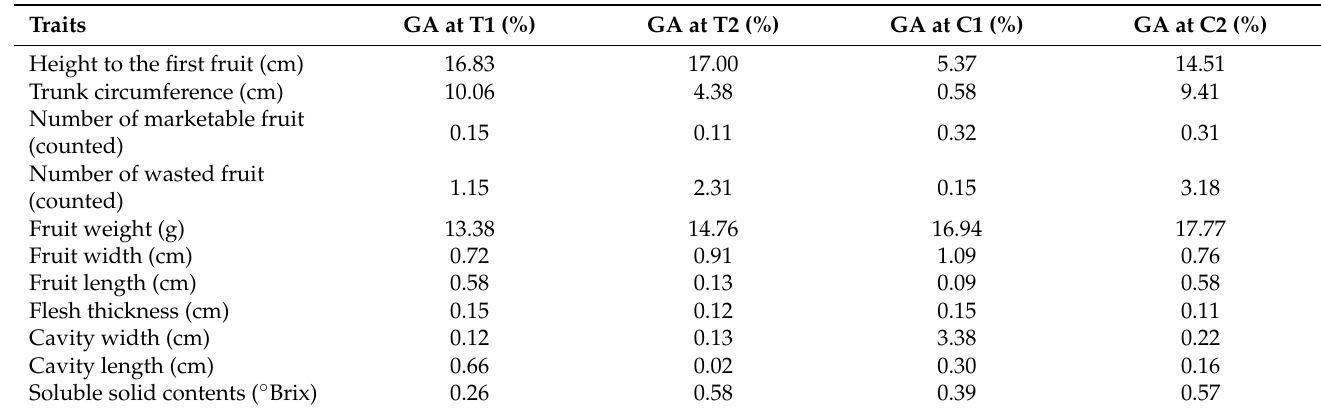
Table 3. Percentage genetic advances (GA) for each trait assessed in the F5 RIL at each environment at a 10% selection intensity. Where T1 and T2 are Tableland trial sites, and C1 and C2 are the Coastal trial sites.